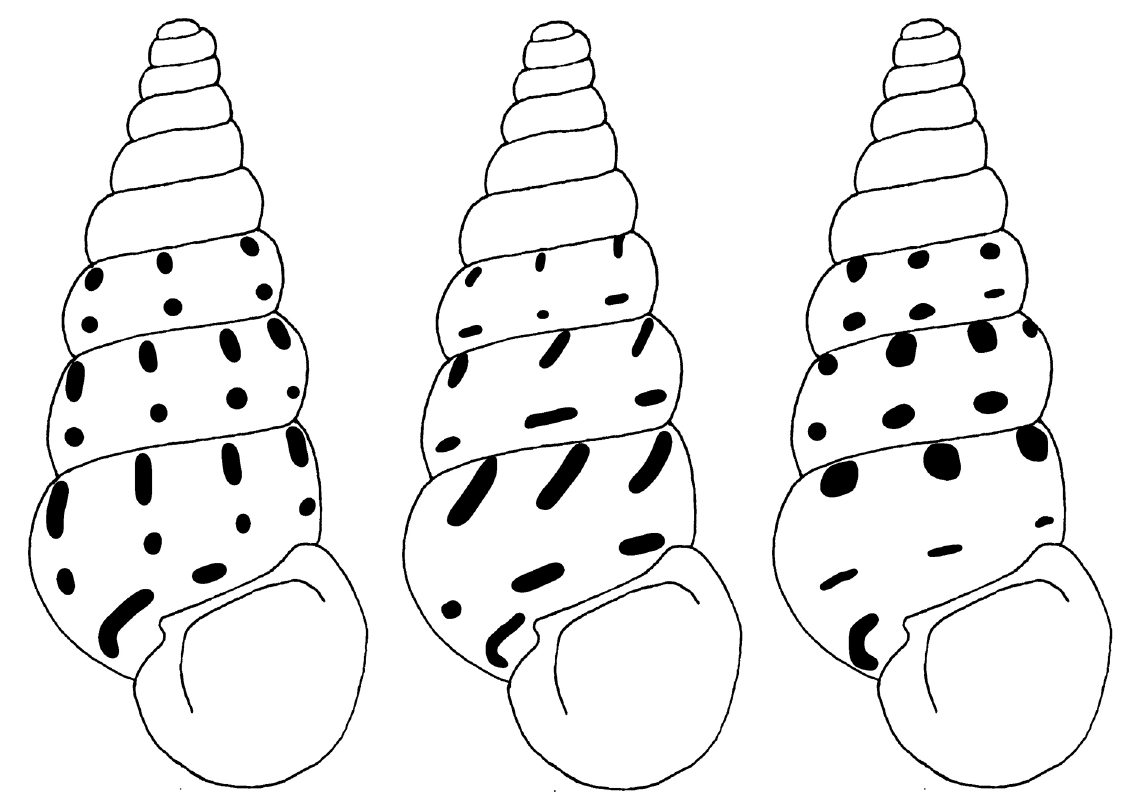
Fig. 12. Most common spot patterns on the shells of the species of Clessiniella Zallot et al .,